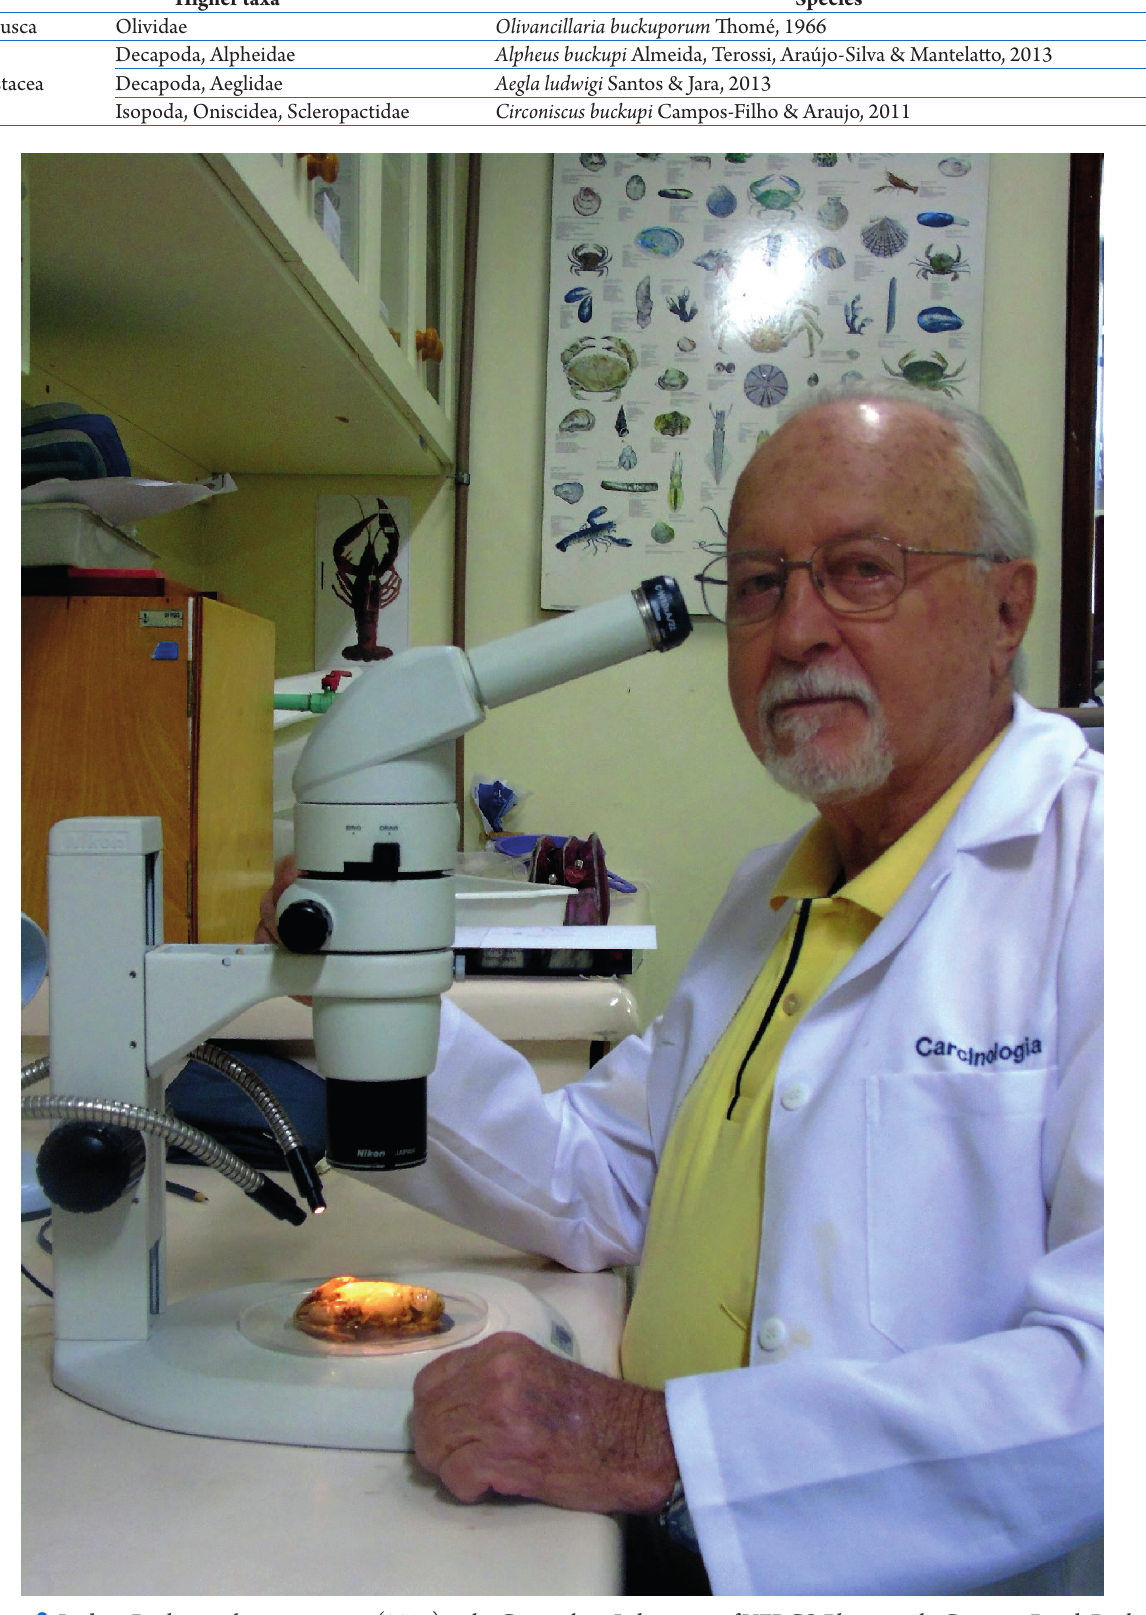
Figure 3. Ludwig Buckup in the present time (2017) at the Carcinology Laboratory of UFRGS. Photograph: Georgina Bond-